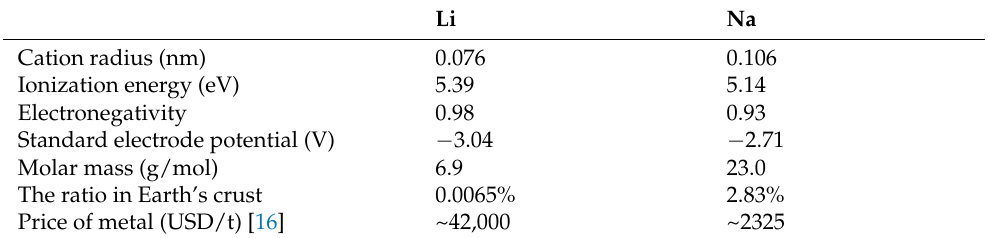
Table 1. Comparison of Li and Na [10–12].